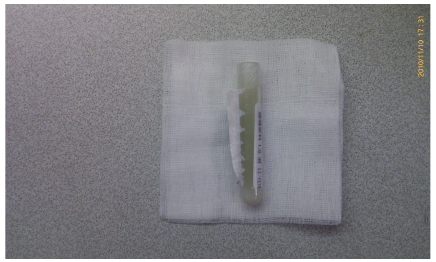
Figure 1: 1 milky ascites.